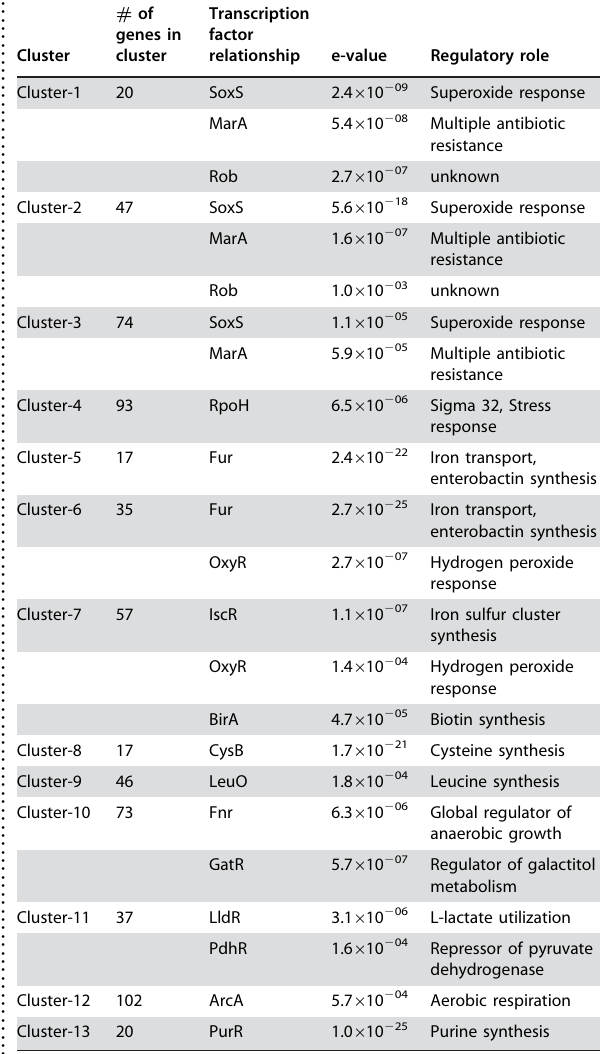
Table 1. Partial summary of Biological Relationship